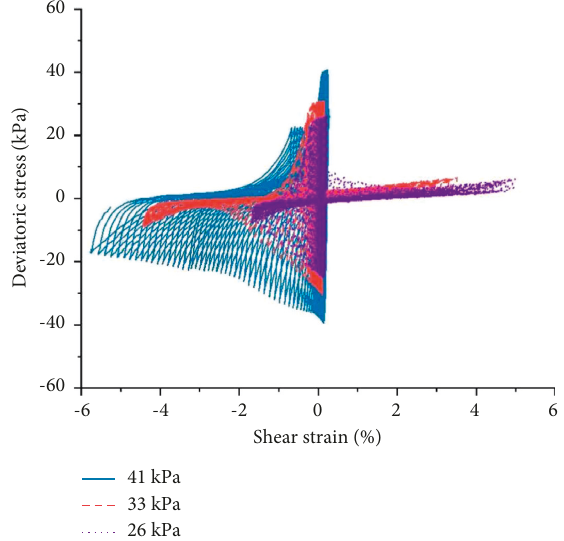
Figure 9: Stress-strain curve of standard sand